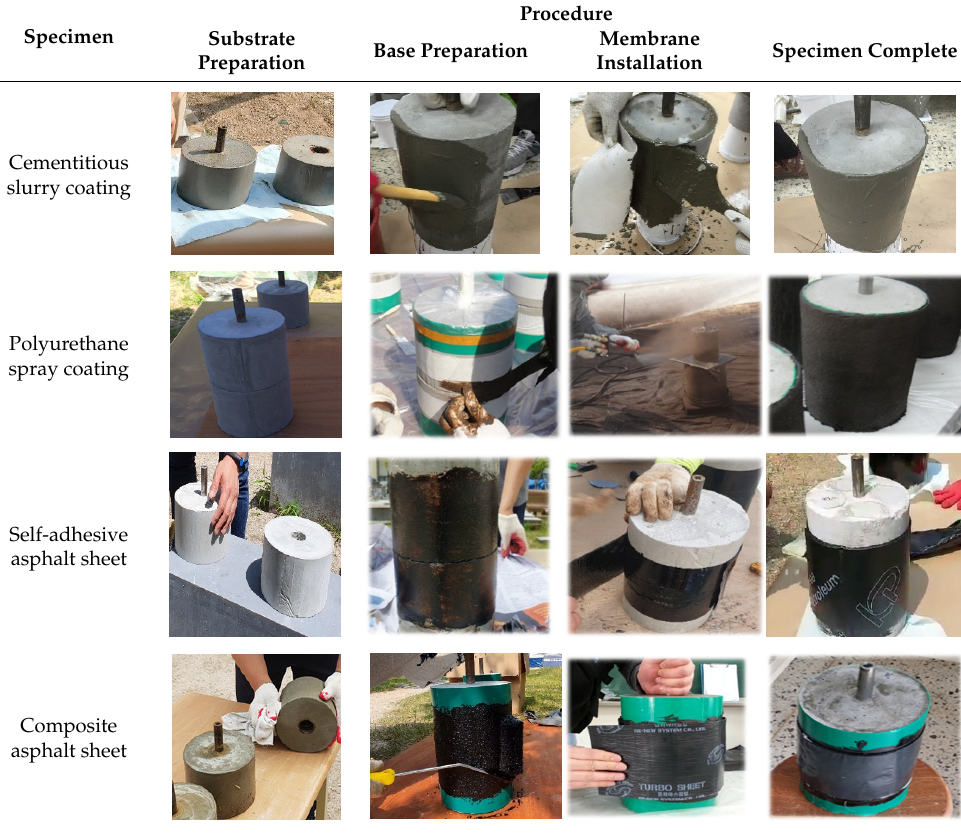
Table 7. Opening range for testing